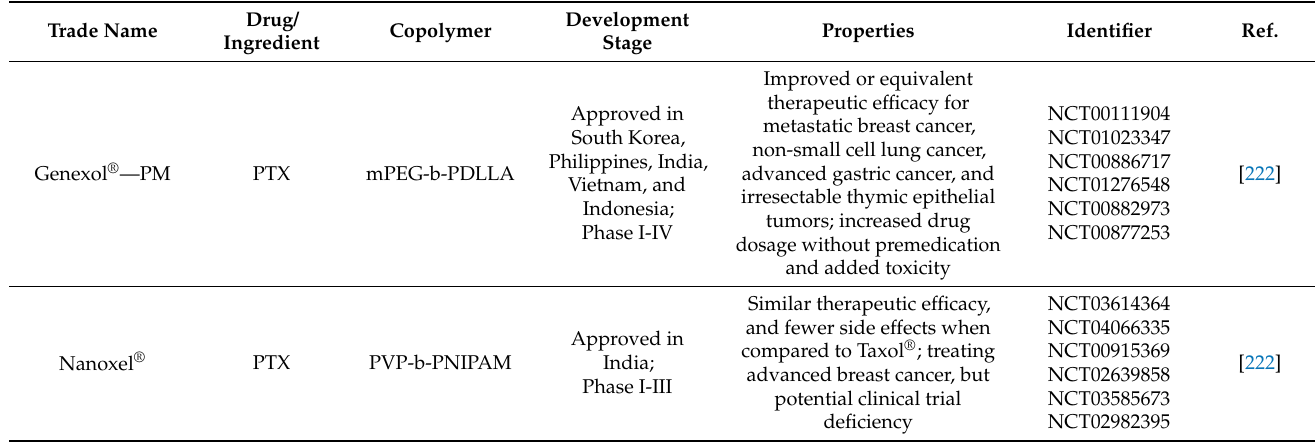
Table 5. Polymeric micellar products under market or under different stages of clinical